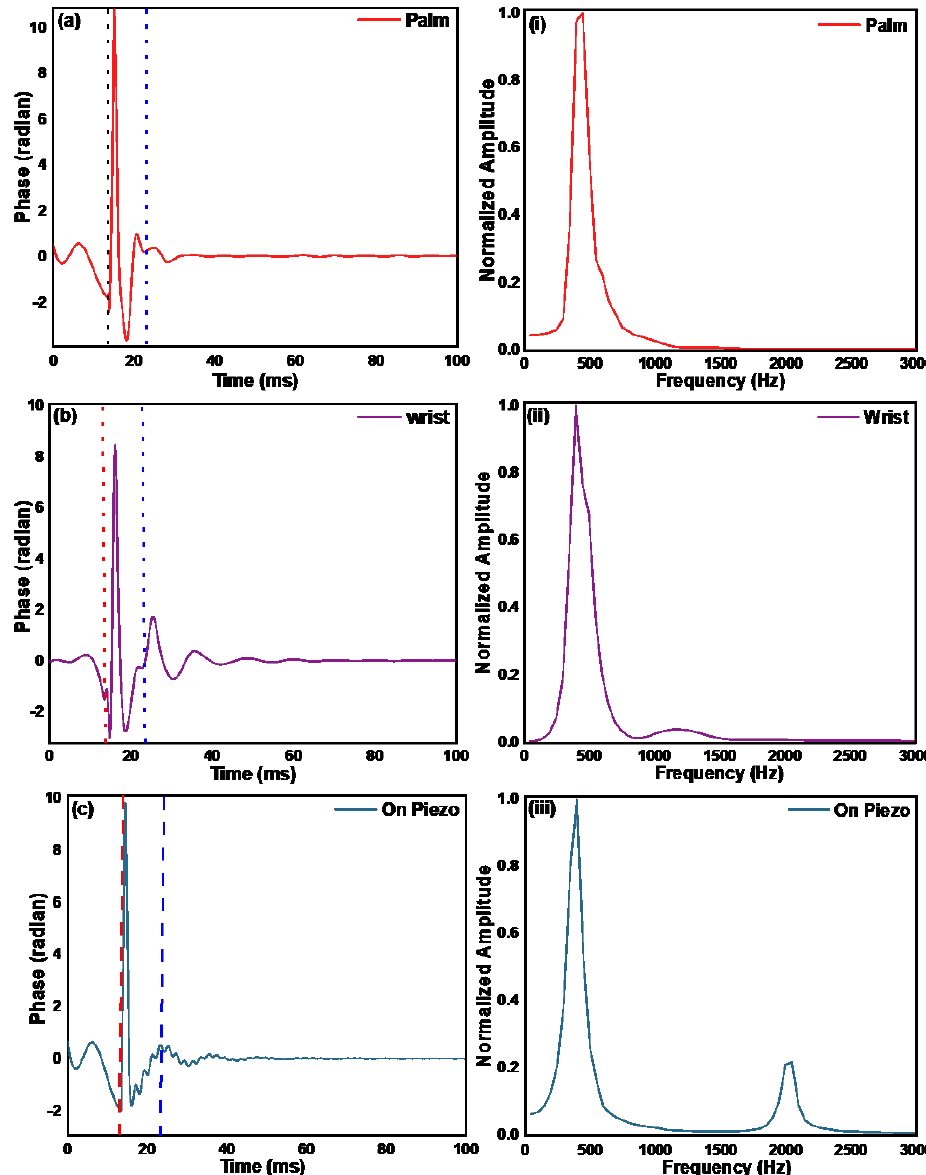
Figure 6. Displacement in terms of phase measured using pulsed excitation on ( a ) palm, ( b ) wrist, and ( c ) directly on piezo. The first dotted red line represents the start of the excitation pulse, and the blue dotted line represents the starting time from where the data were considered for calculation of the resonant frequency. The spectrum of the data after the blue dotted line in ( a – c ) is shown in ( i – iii ), respectively.